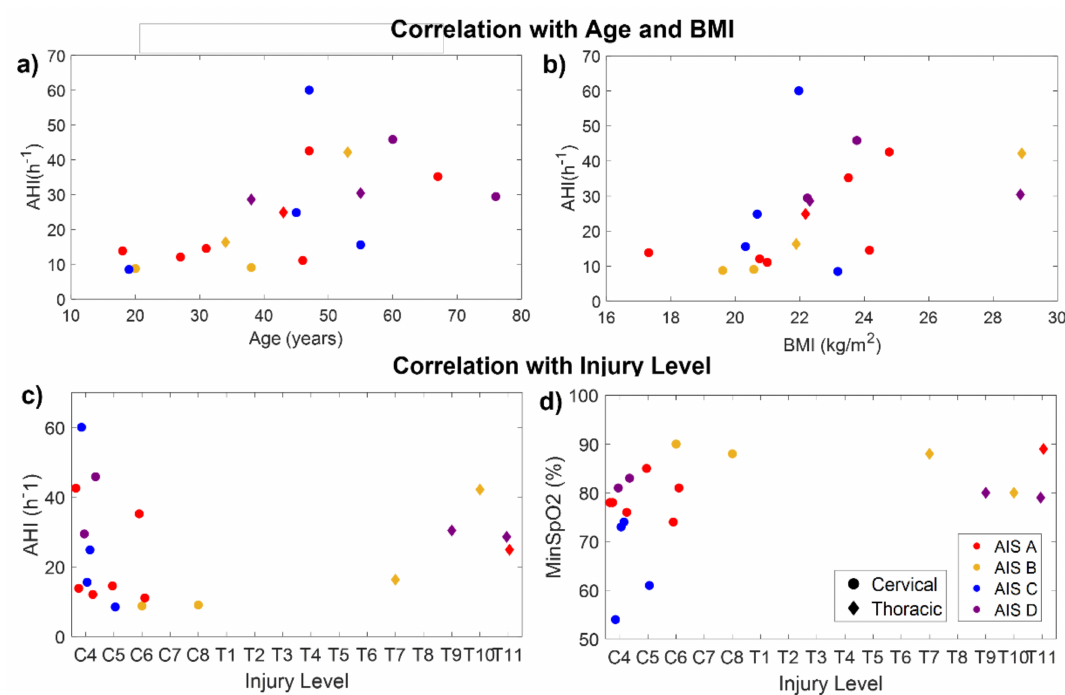
Figure 5. Correlation of AHI with age ( a ), BMI ( b ), and injury level ( c ), and correlation of minimum SpO 2 with injury level ( d ) for the SCI participants. Colors indicate the injury completeness (AIS level). Circles and diamonds indicate patients with cervical and thoracic injuries,